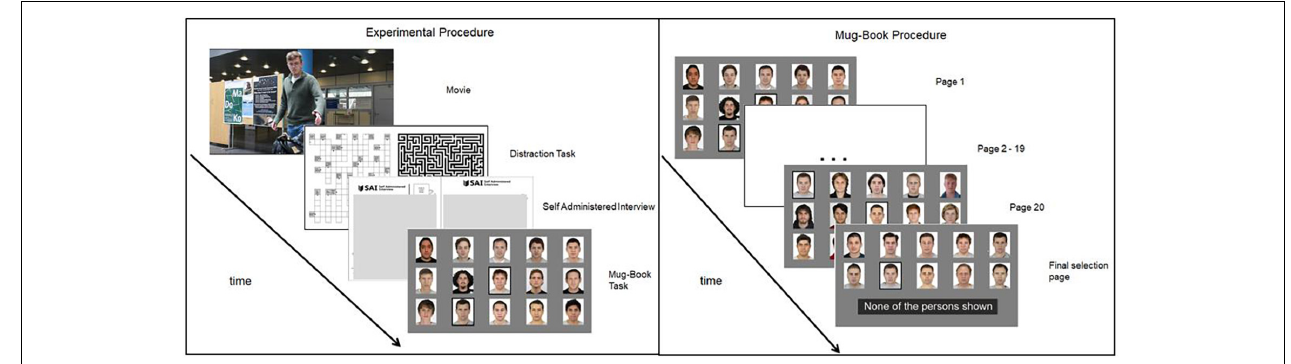
FIGURE 2 | Experimental procedure (left panel): After a movie of a staged crime was shown, participants were given a distractor task for exactly 10 min. Then they were given a Self-Administered Interview (SAI), after which they were asked to complete the mugbook task. Mugbook procedure (right panel): Participants looked through 20 pages with each 15 pictures and were able to choose a person if they think they recognized the culprit. All people selected on the 20 pages were shown on the last page where participants could make a definitive selection or reject the mugbook